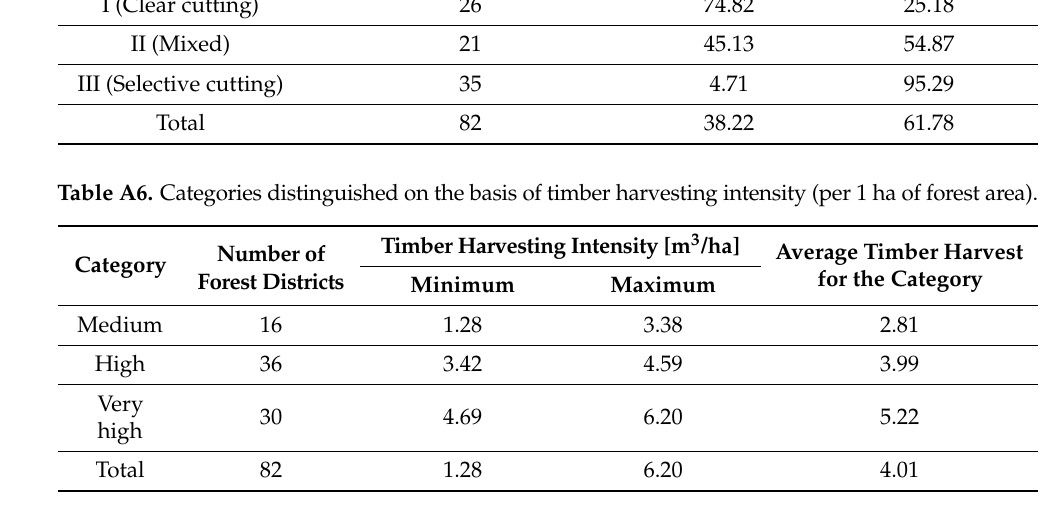
Table A7. Categories distinguished on the basis of the fragmentation of forest